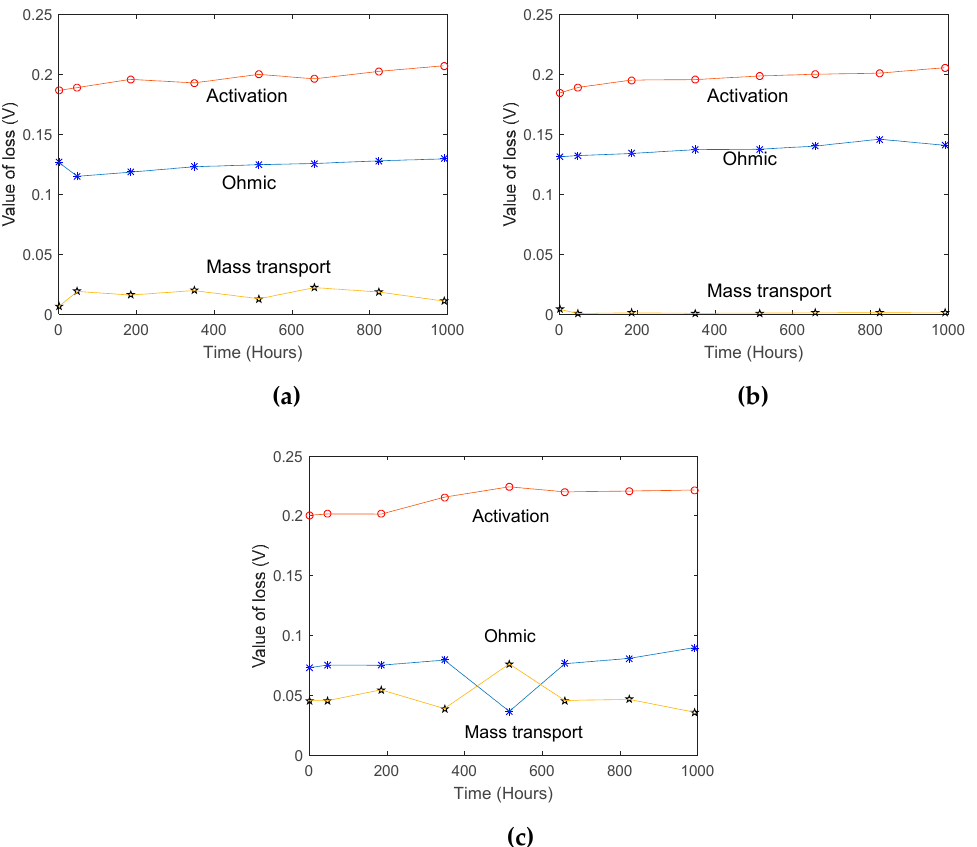
Figure 5. Evolution of three PEMFC losses during the test, using three di ff erent V-I models.